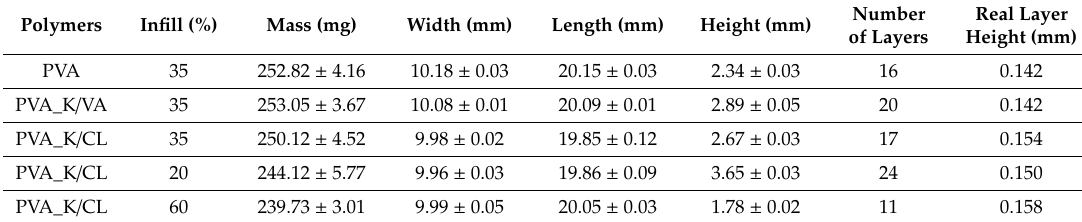
Table 4. Parameters of 3D printed tablets.